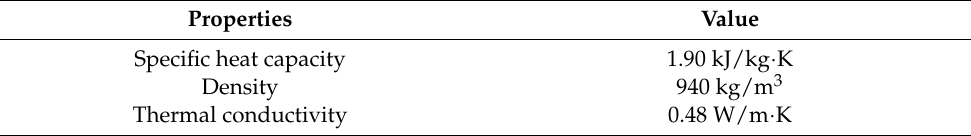
Table 2. Thermophysical properties of plastic container of the PCM slab [24].